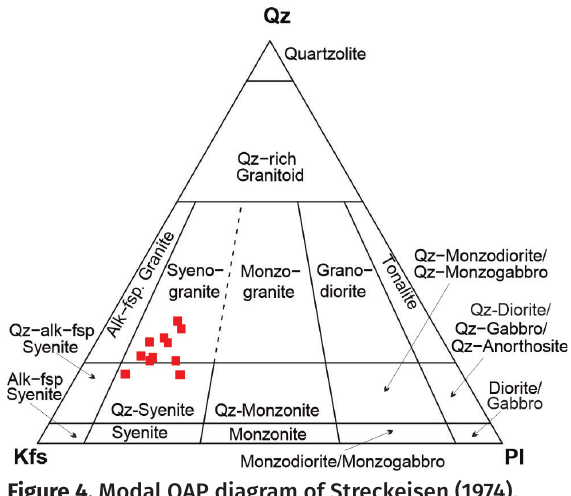
Figure 4. Modal QAP diagram of Streckeisen (1974), showing the composition of the studied